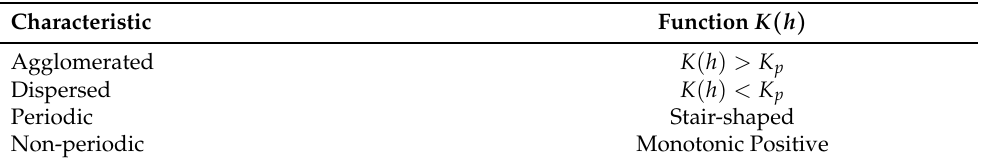
Table 2. Conditions for characterizing a fiber arrangement as agglomerated/dispersed and periodic/non-periodic based on the second-order intensity